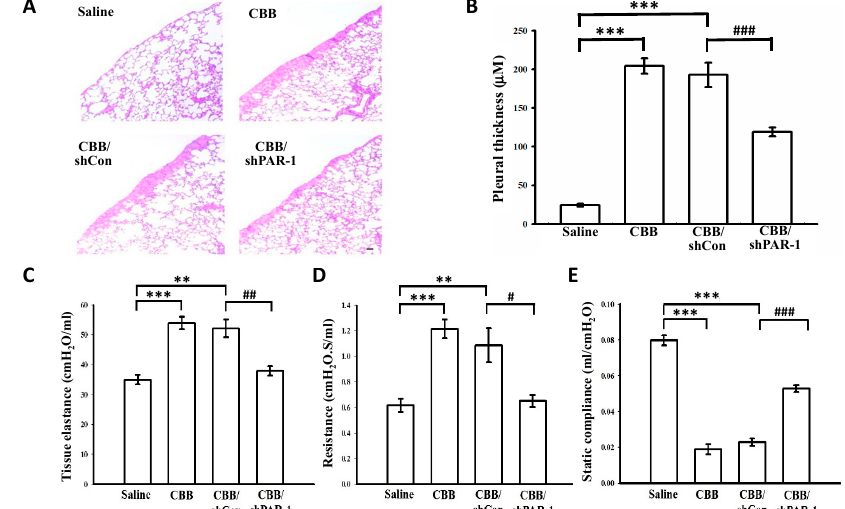
Figure 3. Effects of PAR-1 silencing on pleural thickening and lung function in CBB-induced pleural fibrosis mice model. C57 / B6 mice were treated with saline, CBB, CBB plus control shRNA (shCon) or CBB plus PAR-1 shRNA (shPAR-1) for 14 days. ( A ) The lung tissue sections were harvested and stained with hematoxylin and eosin to determine pleural thickening. The scale bar indicates 50 µ M. ( B ) Pleural thickness from the stained lung sections was measured and collected from 10 fields per slide ( n = 3 representative sections per group). ( C – E ) The assessment of lung function including lung elastance ( C ), resistance ( D ), and compliance ( E ) was also performed. Data are presented as the means SEM ( n = 3). ± *** p < 0.001 compared with the saline control group; # p < 0.05, ## p < 0.01, and ### p < 0.001, compared with the CBB / shCon group. Carbon black / bleomycin (CBB); PAR-1, protease-activated receptor-1; shRNA, short hairpin